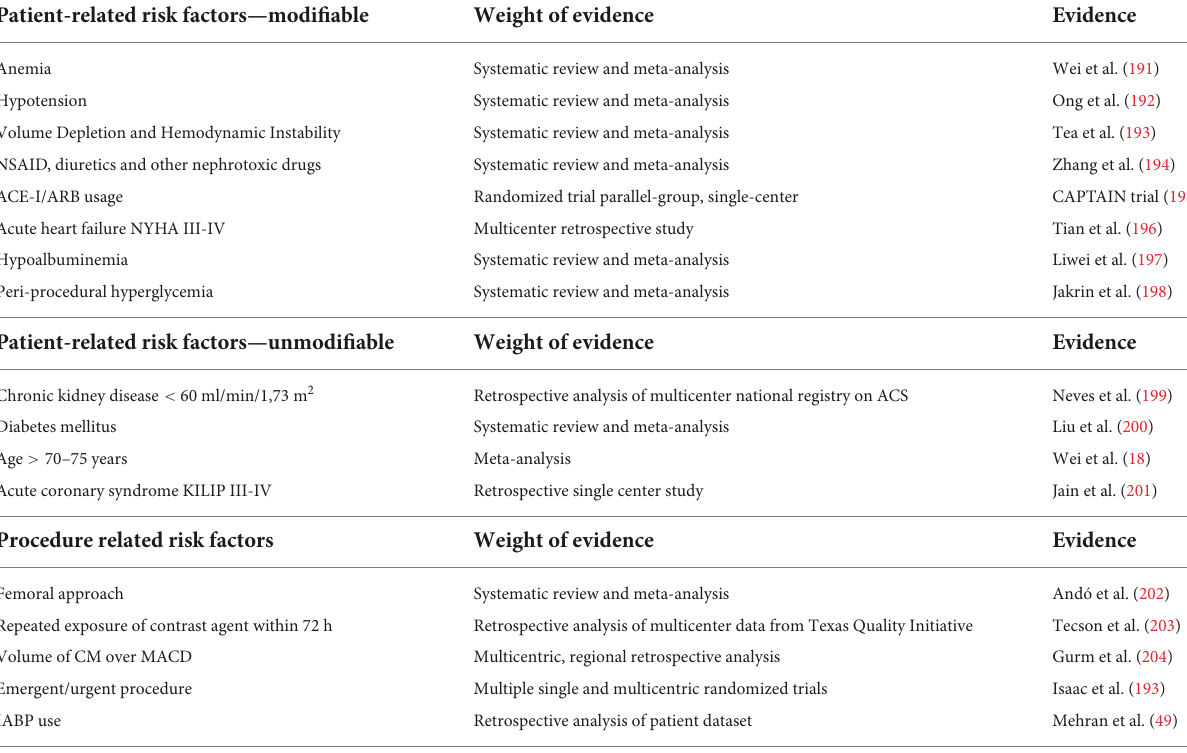
TABLE 3 Proven risk factors of CI-AKI.